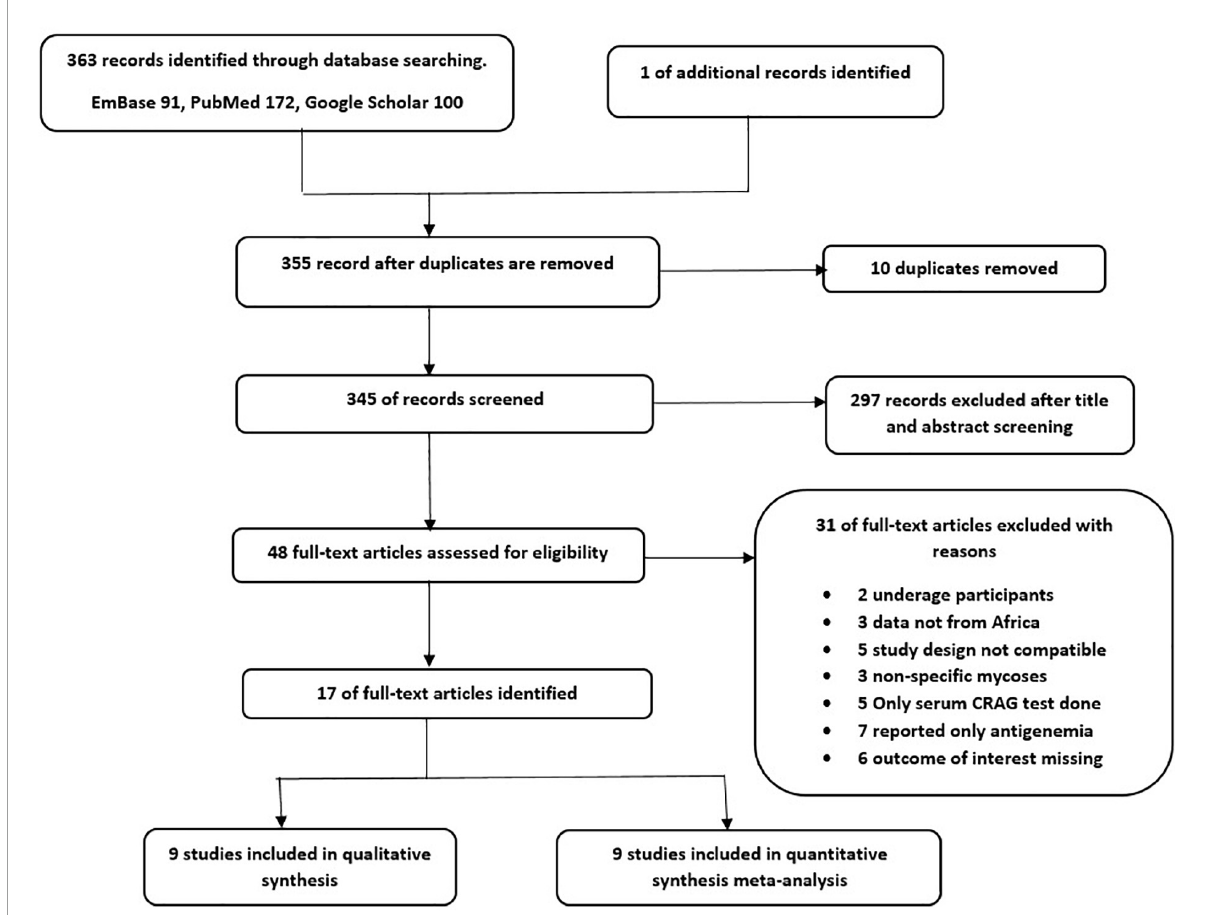
FIGURE1 PRISMA Flow diagram of literature selection (1 study was used in both narrative synthesis and